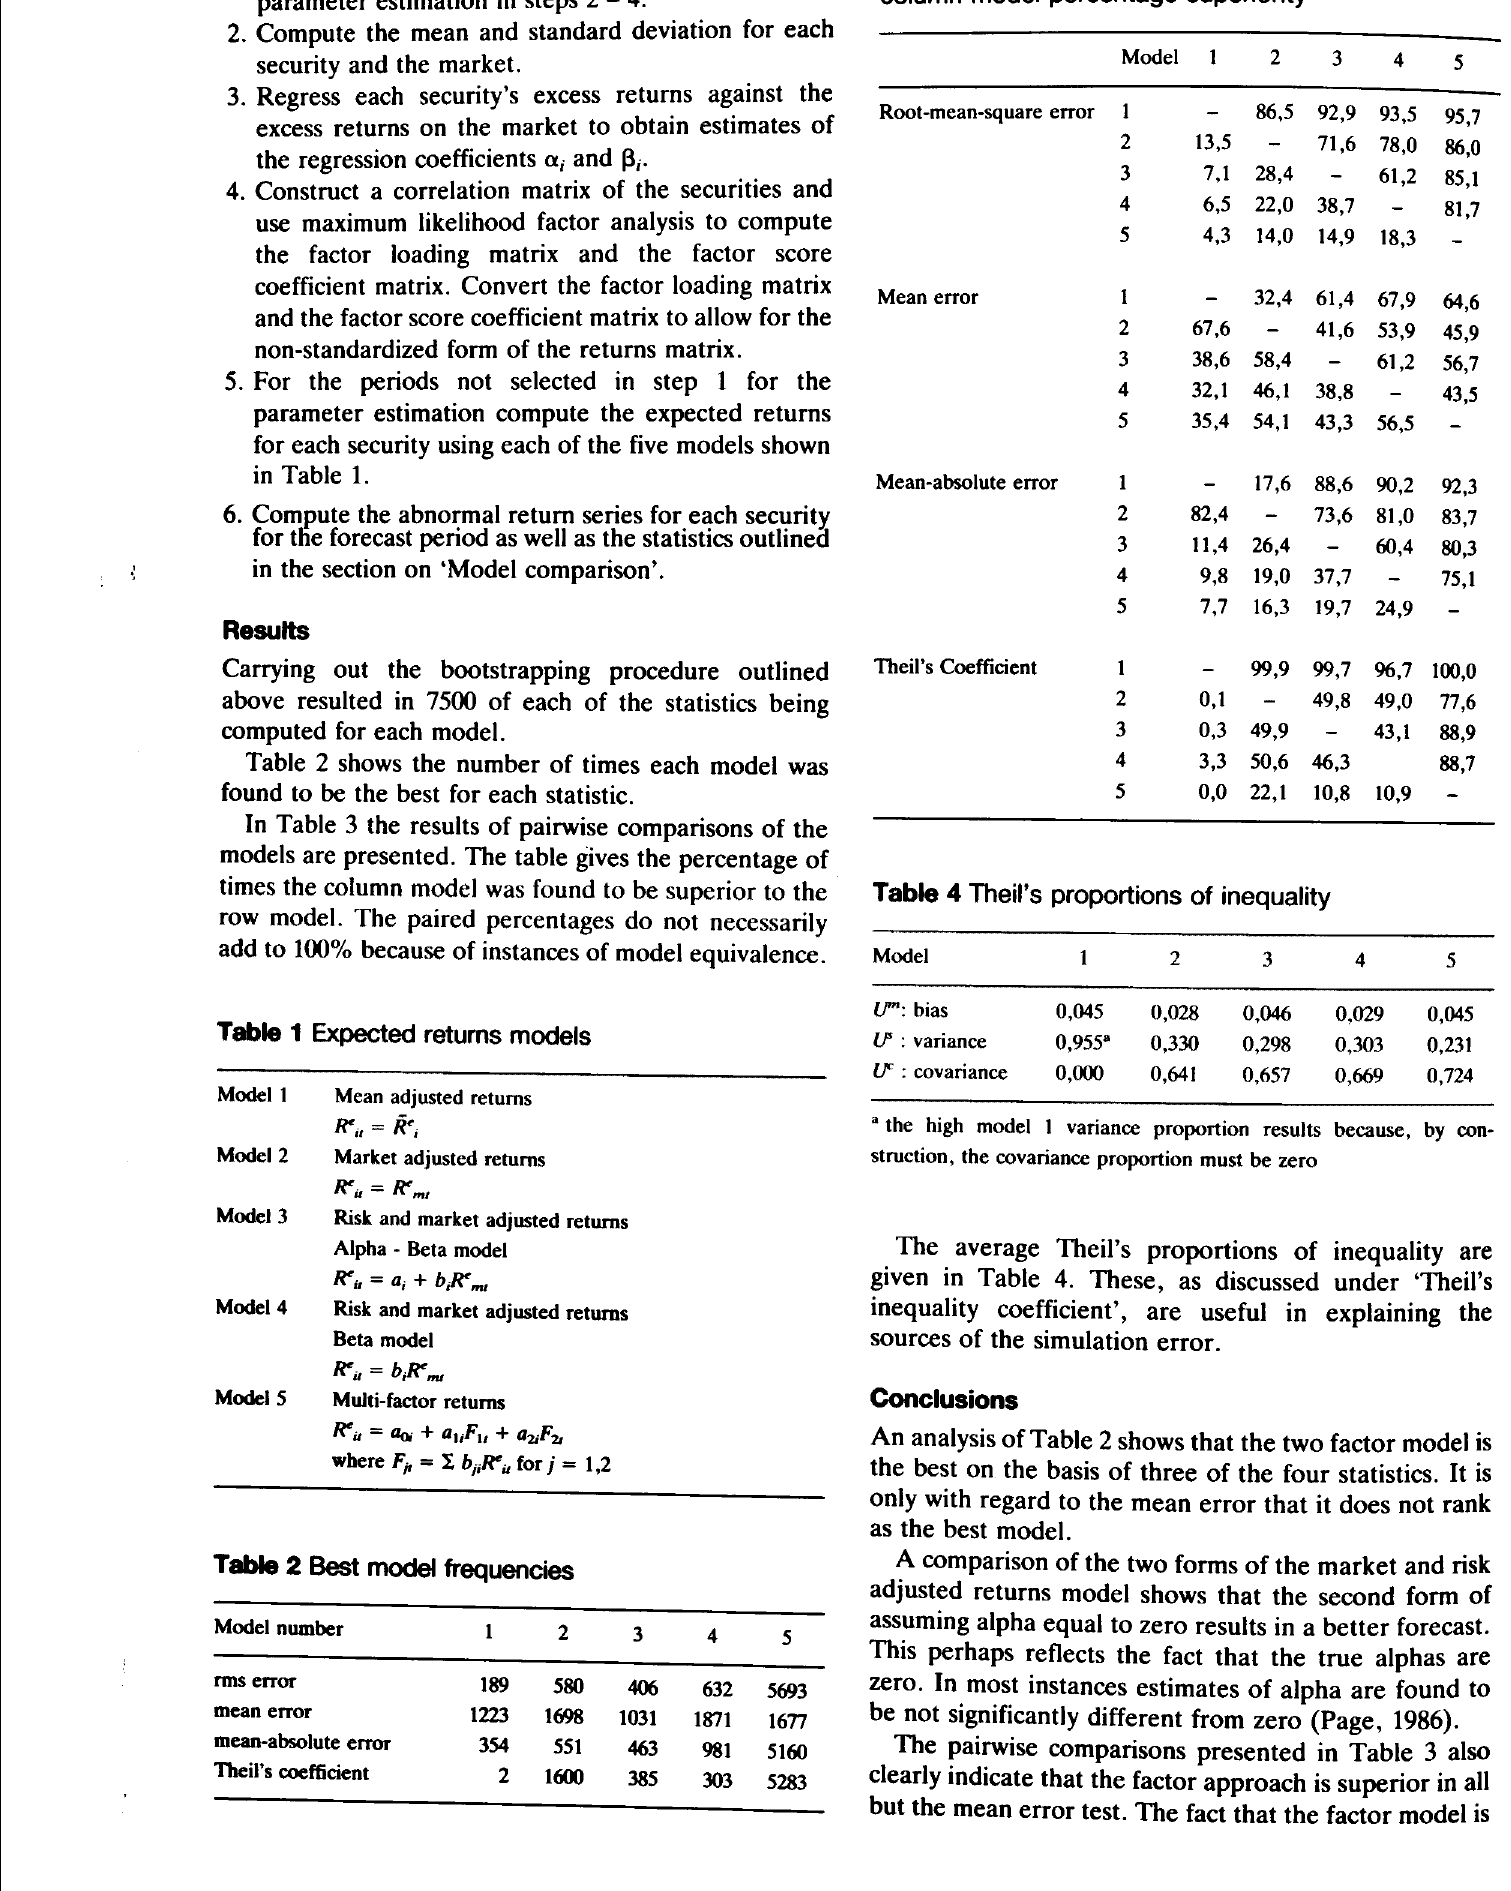
Table 2 Best model frequencies